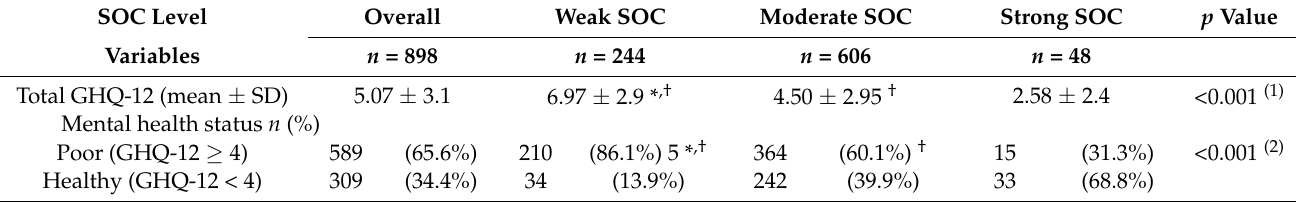
Table 2. Mental health measurements according to sex, clinical workplace phase, and place of residence ( n = 898). SOC Level Overall Weak SOC Moderate SOC Strong SOC p